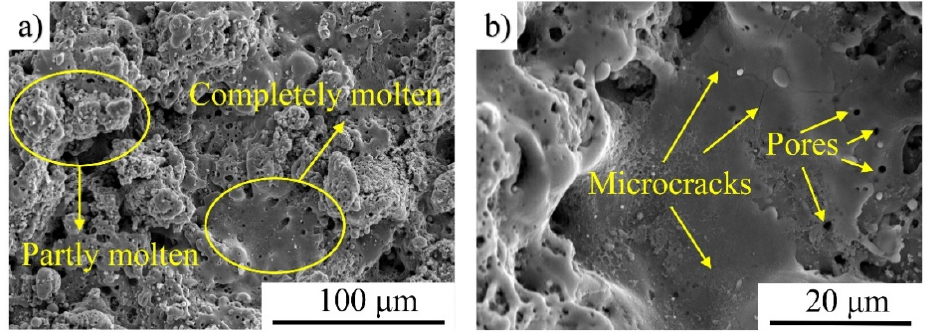
Figure 5. The surface micrographs of the coating: ( a ) low magnification; ( b ) high magnification.